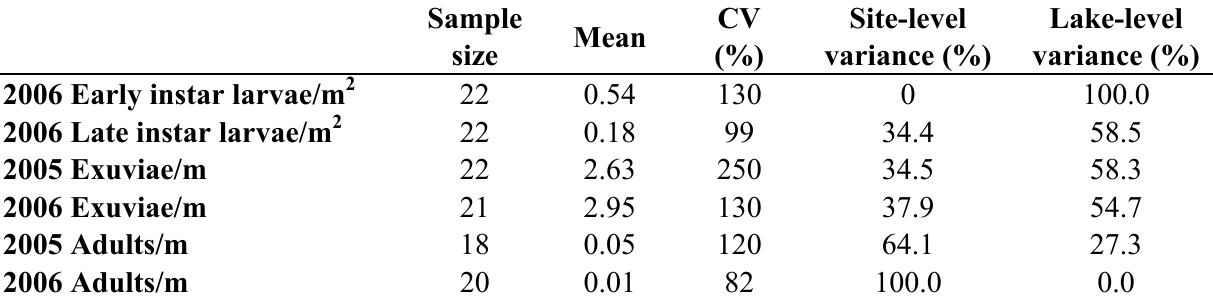
Table 3. Sample size, mean, coefficient of variation (CV), and percent of total variance in densities of four Gomphidae life stages occurring among two 22 sites on 11 lakes.